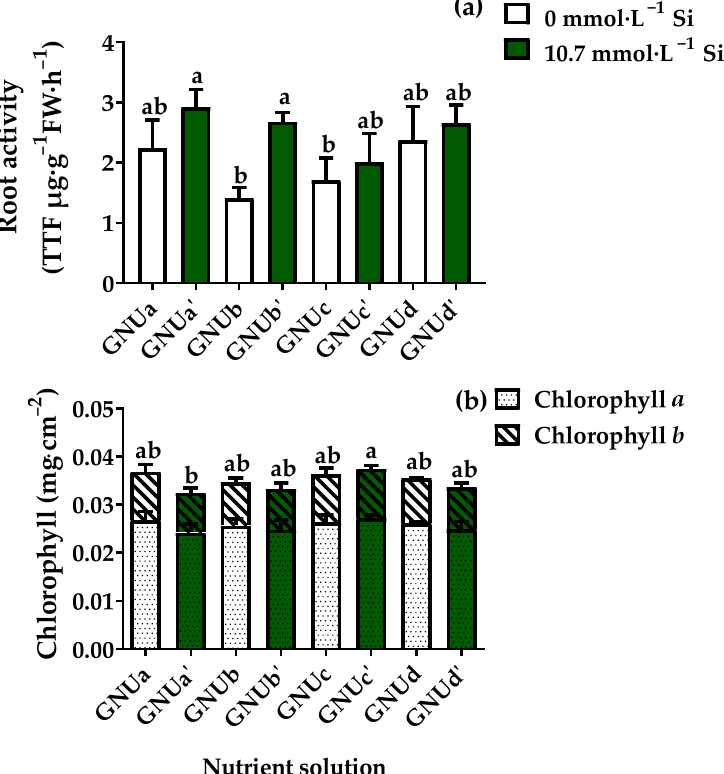
Figure 13. Root activity ( a ) and contents of chlorophylls ( b ) in Ssamchoo as affected by the nutrient solution in Experiment 3. Nutrient solutions had one of four levels of NO 3 − /NH 4+ /urea ratio (GNUa and GNUa‘, 83:17:0; GNUb and GNUb’, 50:50:0; GNUc and GNUc’, 50:25:25; GNUd and GNUd’, 50:0:50) in combination with either 0 (GNUa, GNUb, GNUc, and GNUd) or 10.7 mmol·L − 1 Si (GNUa‘, GNUb’, GNUc’, and GNUd’). Vertical bars in root activity represent the SEs of the three biological replicates ( n = 3). Significant differences in root activity among treatments are indicated by lower- case letters at p ≤ 0.05 according to Duncan’s multiple range test. Vertical bars in chlorophyll con- tents represent the SEs of the three biological replicates ( n = 3) of chlorophyll a and b. Significant differences in total chlorophyll content among treatments are indicated by lowercase letters at p ≤ 0.05 according to Duncan’s multiple range test.